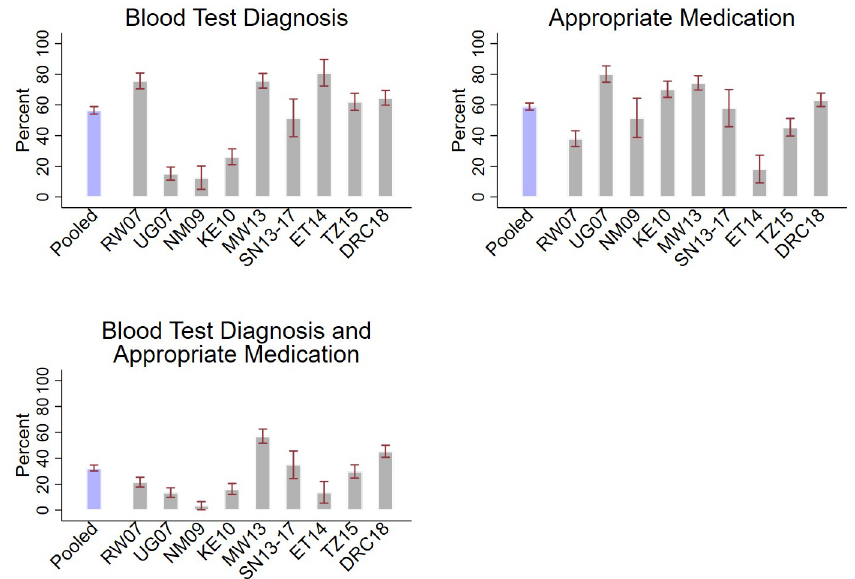
Fig 1. Clinical management of children diagnosed with malaria. Estimates are among the sample of children diagnosed with malaria. “Blood test diagnosis” indicates that the child’s malaria diagnosis was based on either a blood slide microscopy test or a rapid diagnostic test. “Appropriate medication” indicates that the child received either an oral ACT, parenteral artemisinin, or injectable quinine. For Senegal, all 5 survey rounds were combined. Data are weighted by SPA-supplied sampling weights to be nationally representative, and 95% confidence intervals are adjusted for clustering within facilities. ACT, Artemisinin Combination Therapy; DRC18, Democratic Republic of the Congo 2018; ET14, Ethiopia 2014; KE10, Kenya 2010; MW13, Malawi 2013; NM09, Namibia 2009; RW07, Rwanda 2007; SN13-17, Senegal 2013–2017; SPA, Service Provision Assessment; TZ15, Tanzania 2015; UG07, Uganda 2007.